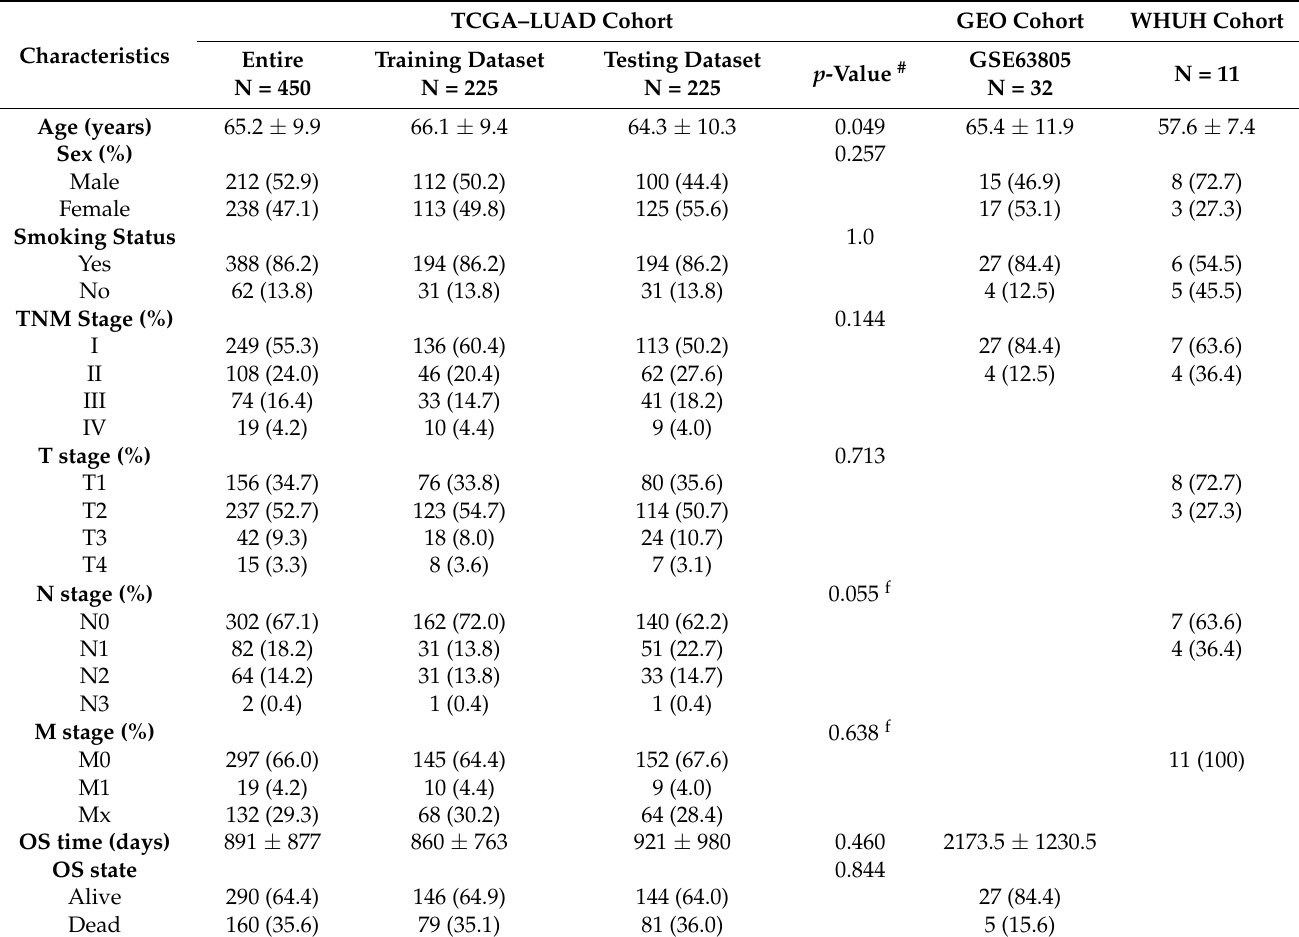
Table 1. Clinicopathological features of the